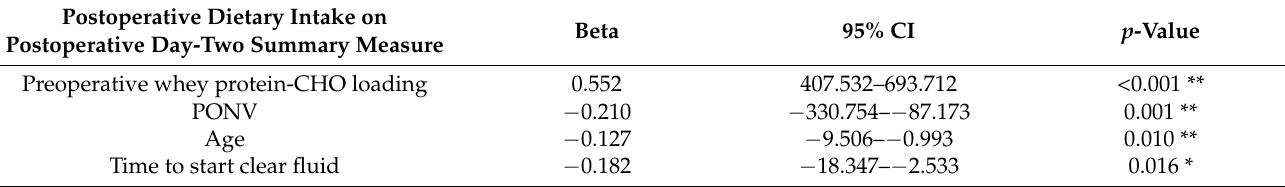
Figure 3. Postoperative total daily protein intake trend. Table 3. Predictors of postoperative dietary intake on postoperative day-two ( N =